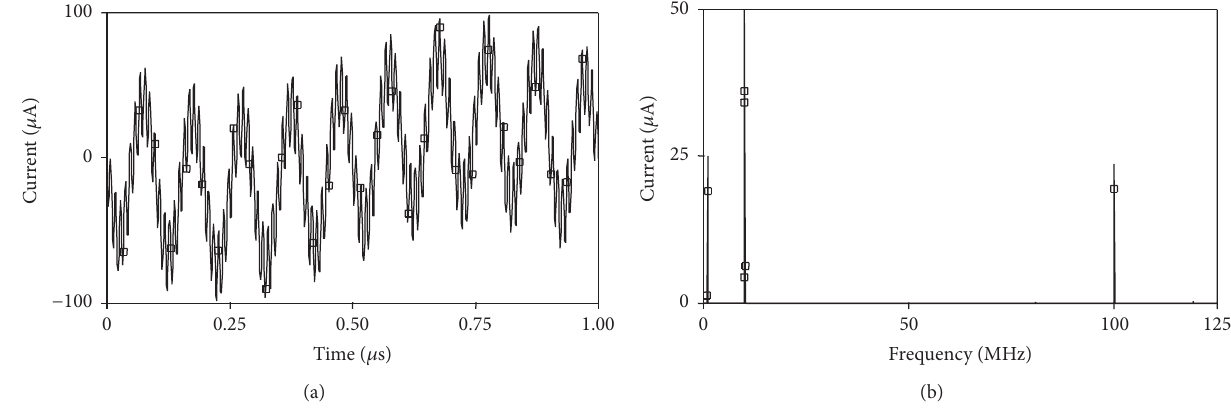
Figure 12: (a) The current input transient signal and (b) its frequency spectrum.